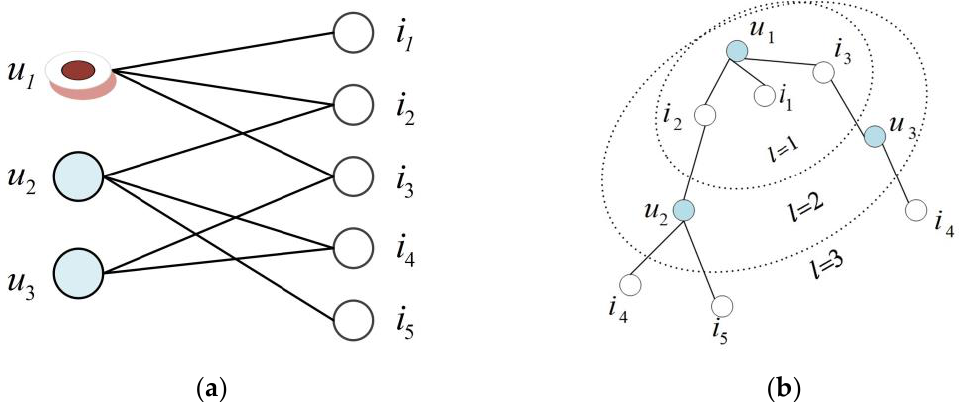
between users and items, we use graph neural network to model the recommendation process. The process is shown in Figure 2 (Take the link process of 𝑢 as an example). The process is mainly divided into three layers: the embedding layer, propagation layer, and rating prediction layer.